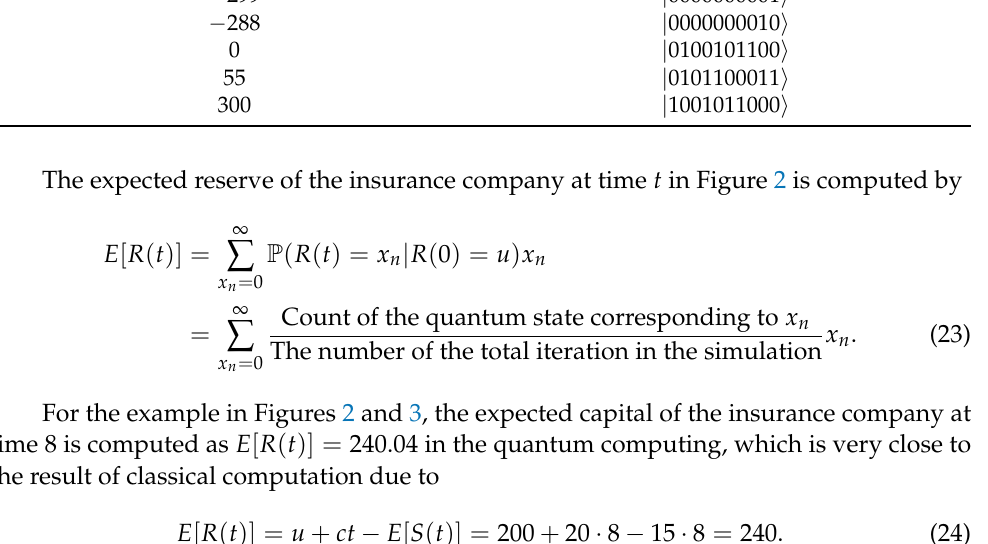
Table 10. Capitals and corresponding basis vectors for 10 qubits. Capital Modified Corresponding Basis Vector −